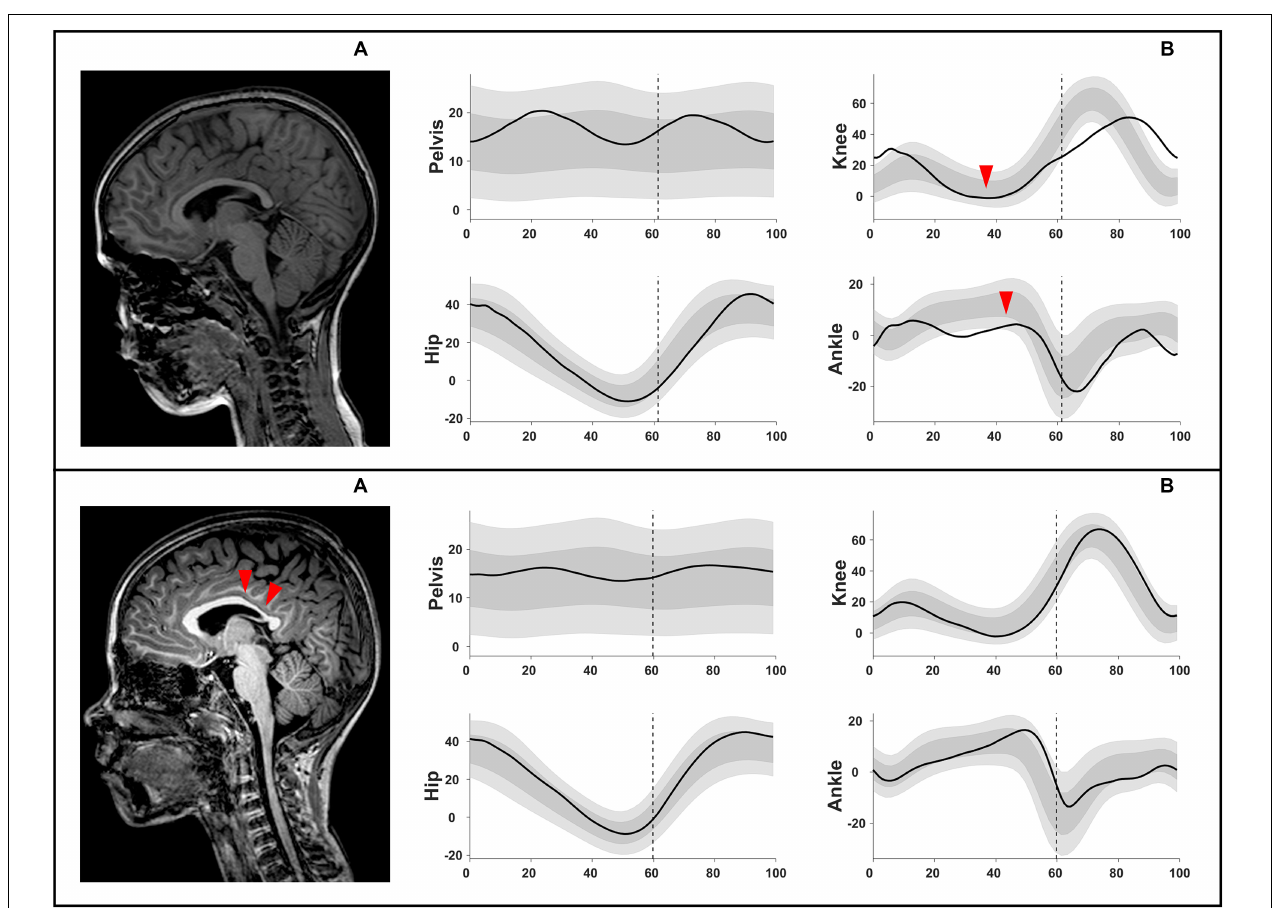
FIGURE 4 | Example illustration of chi-squared analyses, shown in Supplementary Table S6 . Upper row: (A) intact corpus callosum (score 0 out of 3) associated with (B) an extension MJ pattern (increased knee extension during midstance and reduced dorsiflexion). Lower row: (A) corpus callosum with score 2 out of 3 (involved middle and posterior parts) associated with (B) a minor deviations MJ pattern. MJ, multiple joint.